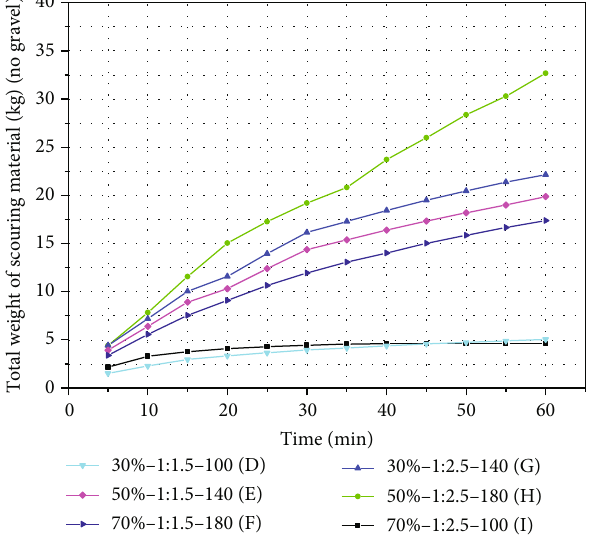
Figure 12: Time-history curve of the total mass of scoured material on gentle